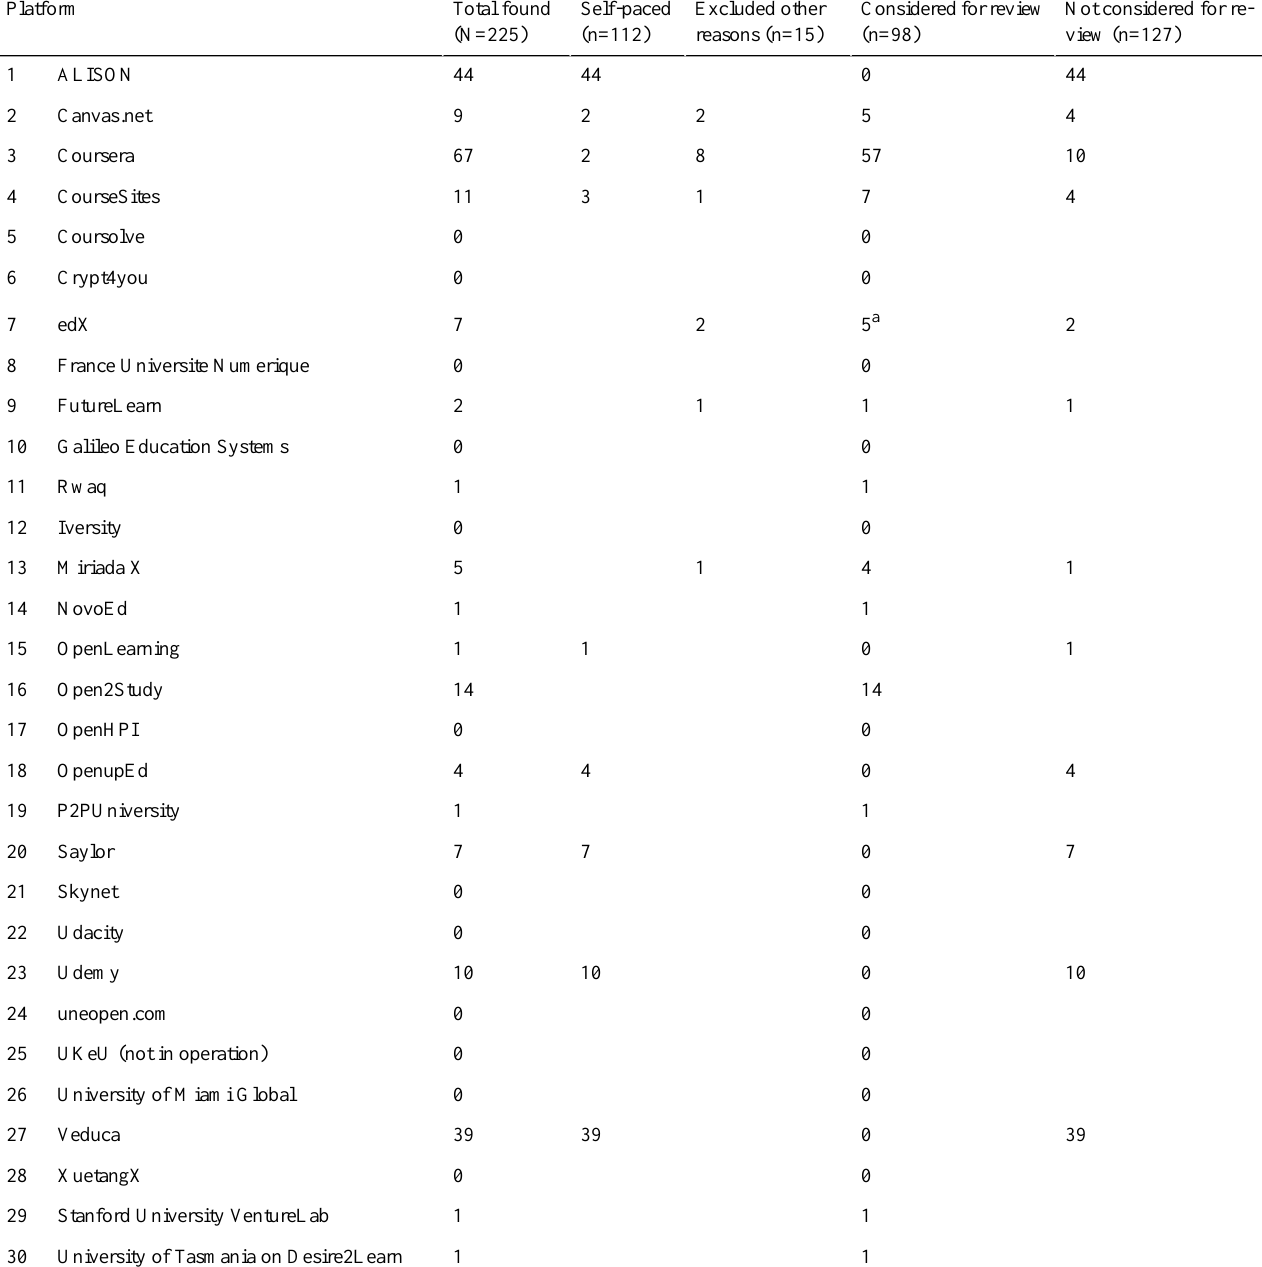
Not considered for